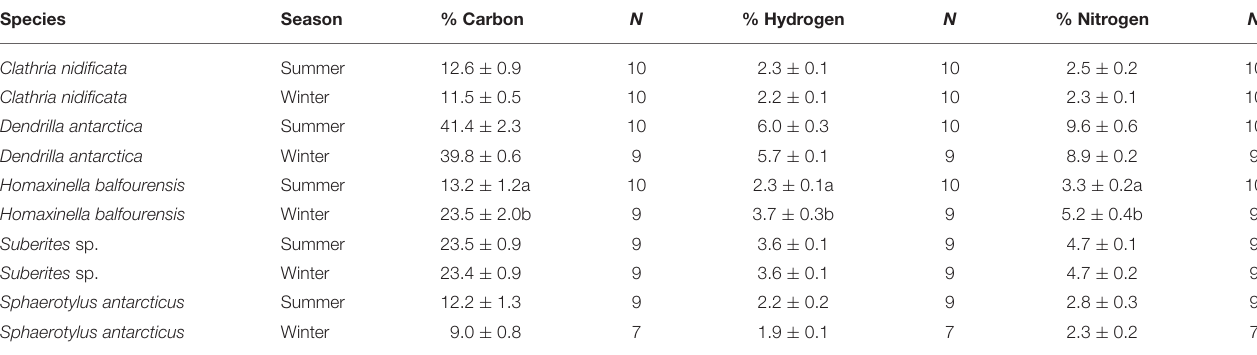
TABLE 3 | Proximate composition, total % Carbon, Hydrogen, and Nitrogen content, of dried tissue of sponge species in summer and winter. Species